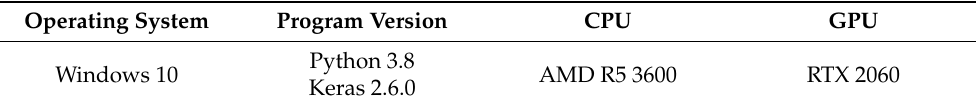
Table 2. Experiment execution